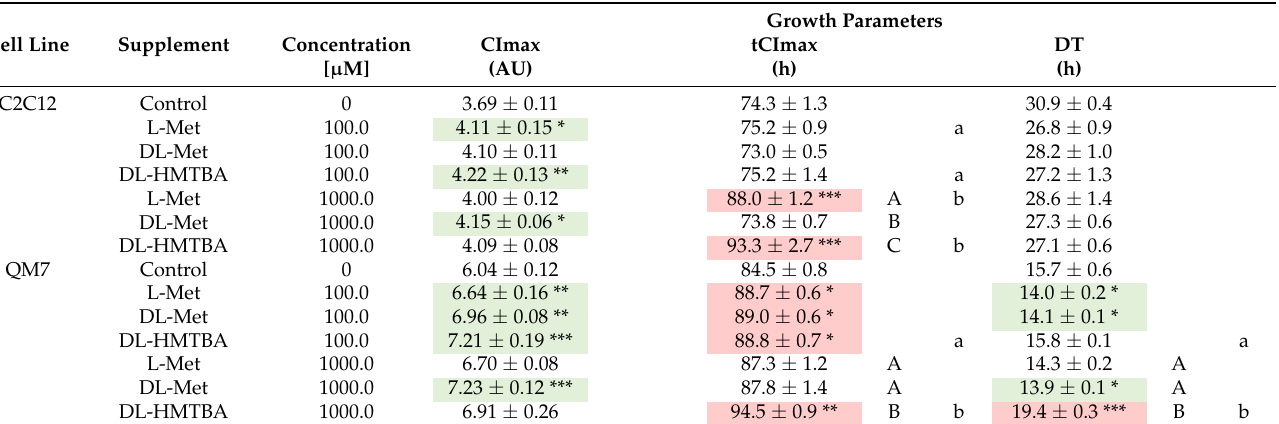
Table 1. Kinetic growth parameters of murine C2C12 and avian QM7 cells after supplementation with L-Met, DL-Met, and DL-HMTBA.